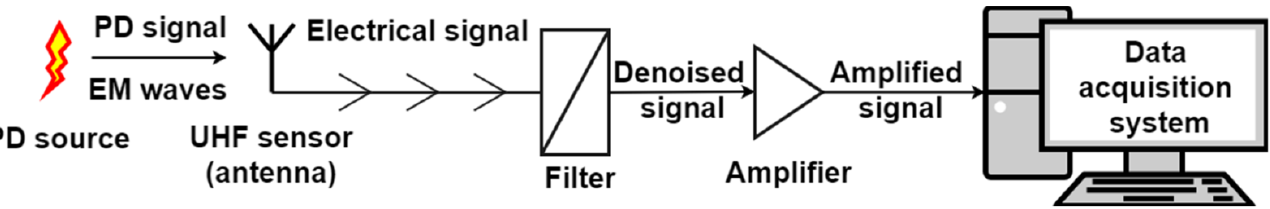
Figure 12. The principal of VHF/UHF detection